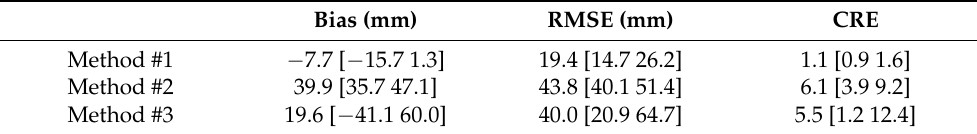
Table 2. Summary of the performance evaluation of different methods for internal accuracy verification.